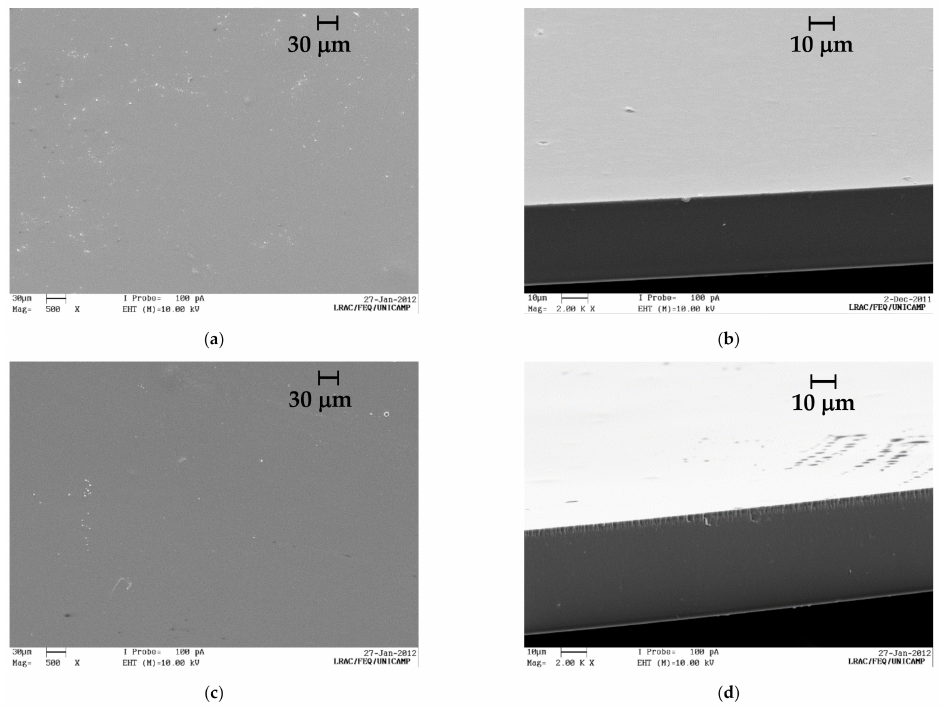
Figure 2. SEM images of the chitosan 2.0% films containing aloe vera extract. ( a ) Surface and ( b ) cross-section of a CH2-AV1 film at magnifications of 500 × and 2000 × , respectively; and ( c ) surface and ( d ) cross-section of a CH2-AV2 film at magnifications of 500 × and 2000 × ,